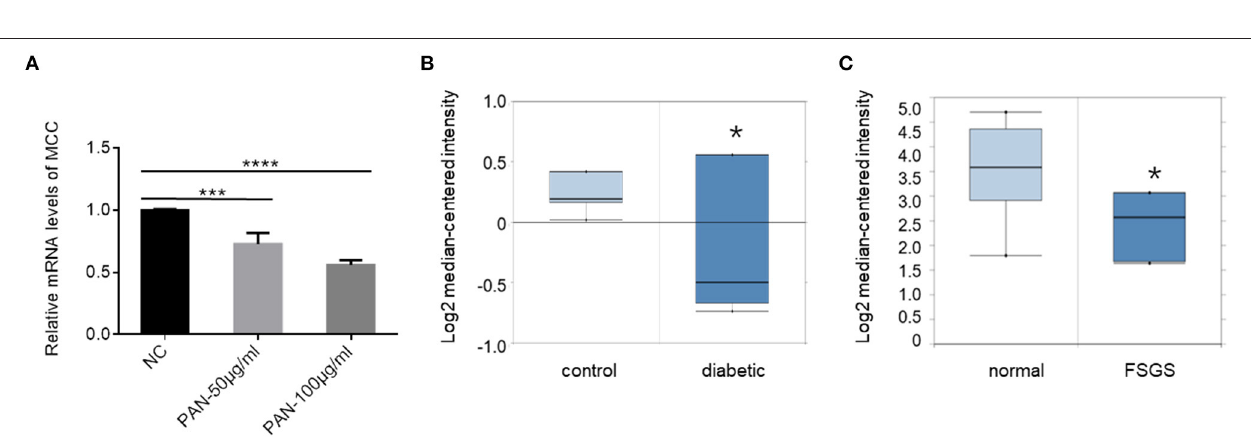
FIGURE 9 | Requirement of MCC in lamellipodium formation of podocytes. (A) Fluorescence immunostaining of MCC and F-actin (phalloidin) shows that MCC protein is abundant in lamellipodia (arrows), and its knockdown caused loss of lamellipodia (arrow head) in the podocytes. (B) Fluorescence immunostaining of lamellipodial marker, cortactin, further shows the loss of lamellipodia in the cells lacking MCC (arrow head).